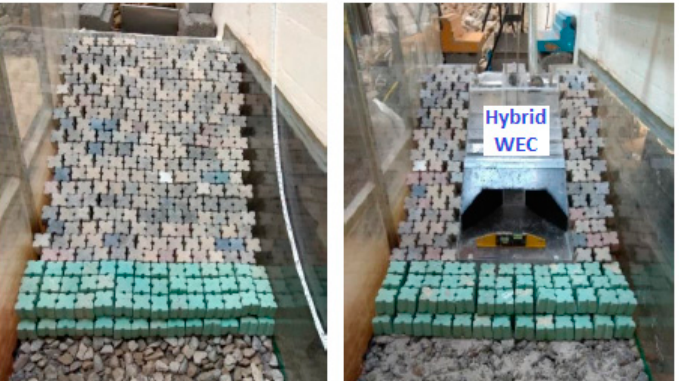
Figure 8. Photographic record of integrated hybrid WEC in a breakwater, 2D physical model without WEC on the left and with WEC on the right .